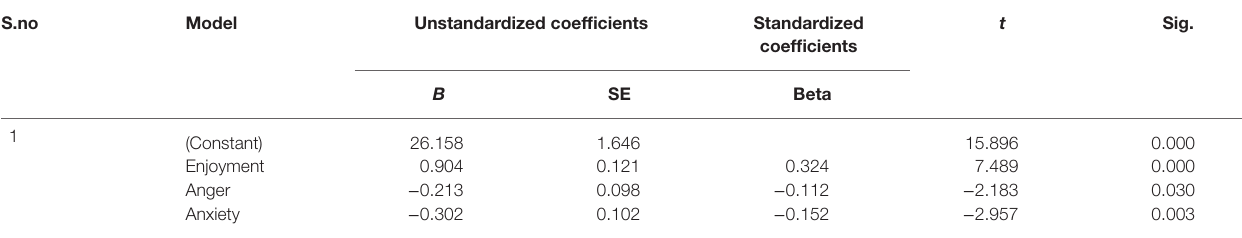
TABLE 5 | Coefficients for teachers’ resilience and components of teachers’